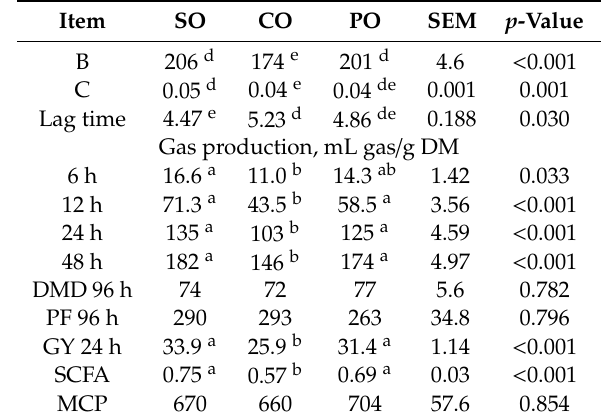
Table 6. in vitro rumen gas kinetics, cumulative gas production and rumen fermentation profile, after 96 h of incubation in goat diets supplemented with sa ffl ower oil (SO), canola oil (CO) and palm oil (PO) treatments 1 .